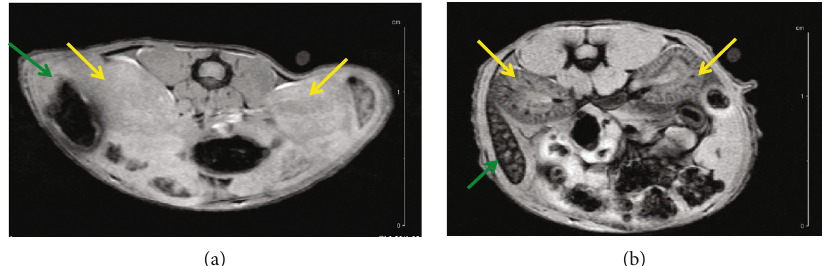
Figure 4: FLASH-kidney prescan (a); FLASH-kidney 60min p.i. (b). Annotation shows the liver (yellow arrows) and the spleen (green arrows).